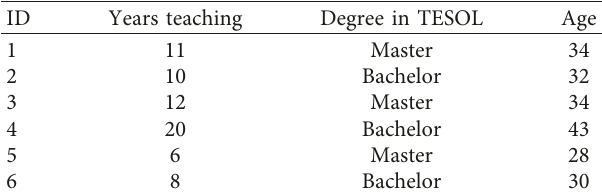
Table 1: Participants of the pilot group.